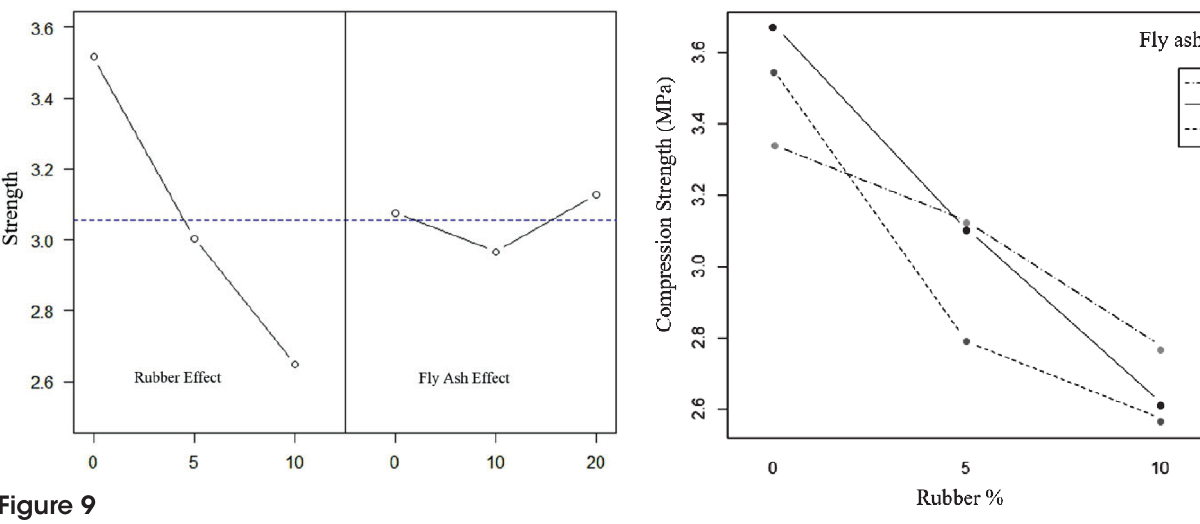
and their effects represent 81% of the variability of the measure - ments. The results show that the variability among replicas does not display any lack of adjustment considering the second order terms (quadratic function), as the p-value (0.346) > α (0.05), as this means the measurements are equal to the replicas. Figure 11 exhibits the behavior of the residuals (the difference between the experimental values and those predicted by model) regarding distribution in normality and randomness. Presently, it is possible to confirm that the model is adequate for describing the behavior of compressive strength in mortars as a factor function in rubber and fly ash, as the residuals are approximately distributed along a straight line and randomly scattered. According to the Bartlett test, errors due to the effects of rubber and fly ash factors exhibit constant variance. This specific test is characterized by the following hypotheses: the null hypoth- esis confirms that variances are constant and the alternative hy - pothesis confirms that variances do not display homogeneity.